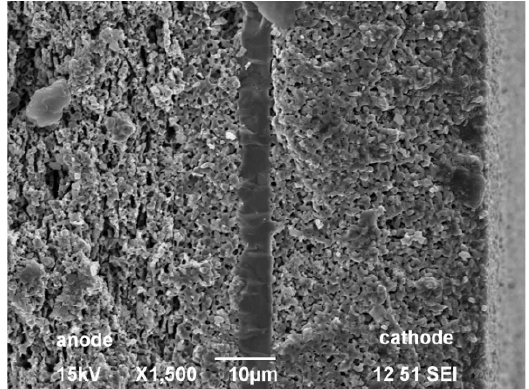
Figure 10. Post-test SEM microstructure of the AS-SOFC cell (reference test with no contaminants in the